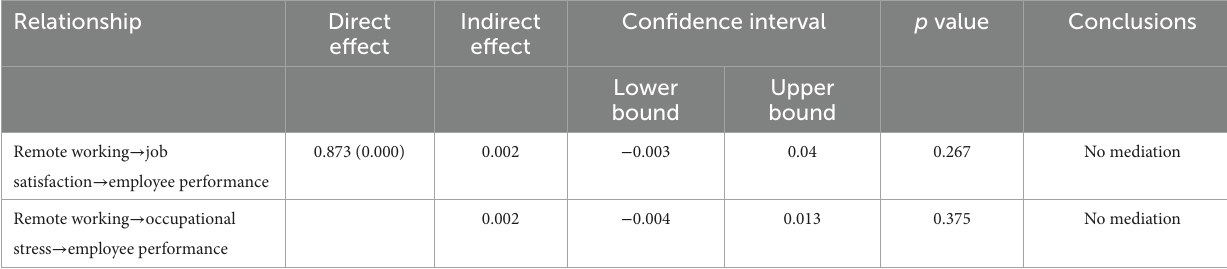
TABLE 10 Summary of mediation